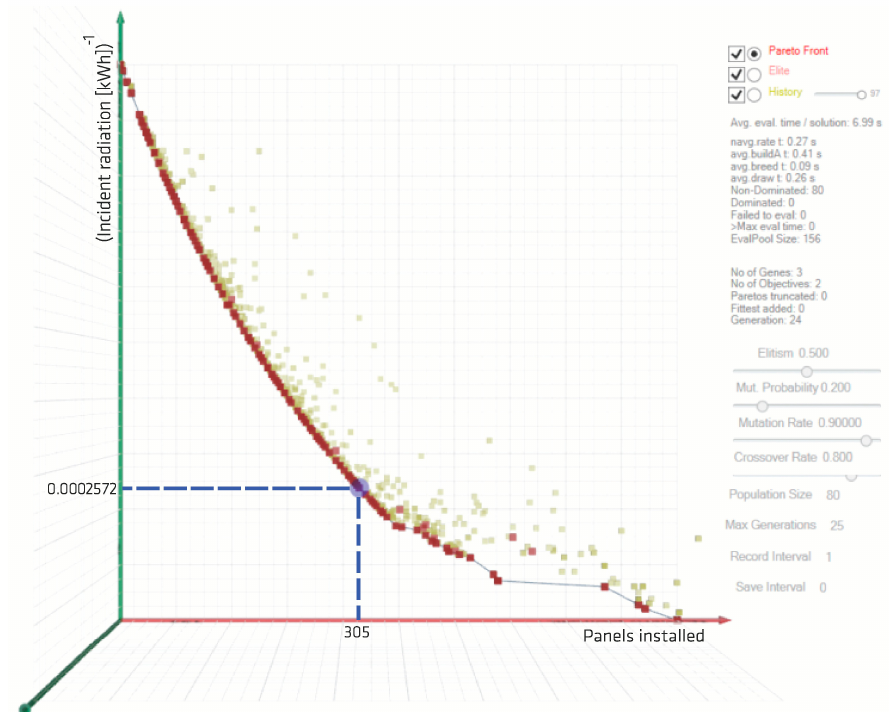
Figure 8. Octopus optimization results displaying the Pareto front. In the graph, the number of installed panels is reported on the X-axis while the Y-axis collects the values for incident radiation. Since the algorithm works by minimizing the output of interest, this latter value was considered reversed. The Pareto front collects the non-dominated solutions: the red dots express the maximum radiation achievable with a fixed number of panels.